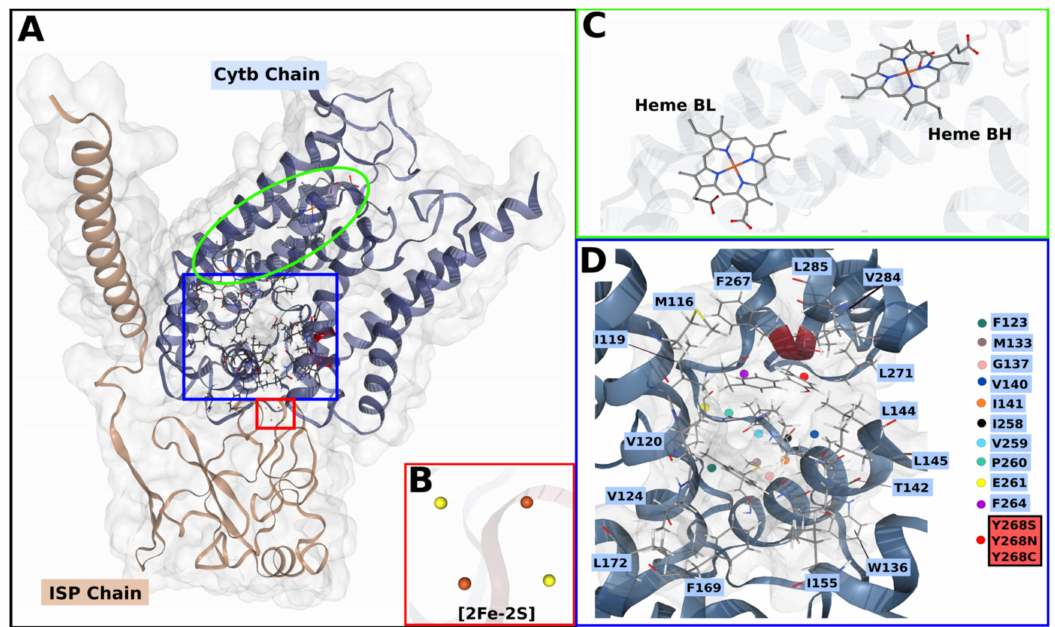
Figure 2. 3D cartoon representation of PfCytb-ISP protein complex. ( A ) PfCytb-ISP structure with different subunits color coded (key provided) and labelled accordingly. The red, green and blue delimitations indicate the [2FE-2S] cluster, the heme groups and the active site, respectively. ( B ) [2FE-2S] cluster, showing sulphur atoms in yellow and Fe 2+ atoms in orange. ( C ) Heme bL and bH groups. ( D ) The zoomed in active site showing its contributing residues which are highlighted in blue. The point mutations at position 268 are shown in the red colored box and indicated by a red sphere in the active site. This position is also colored red on the cartoon